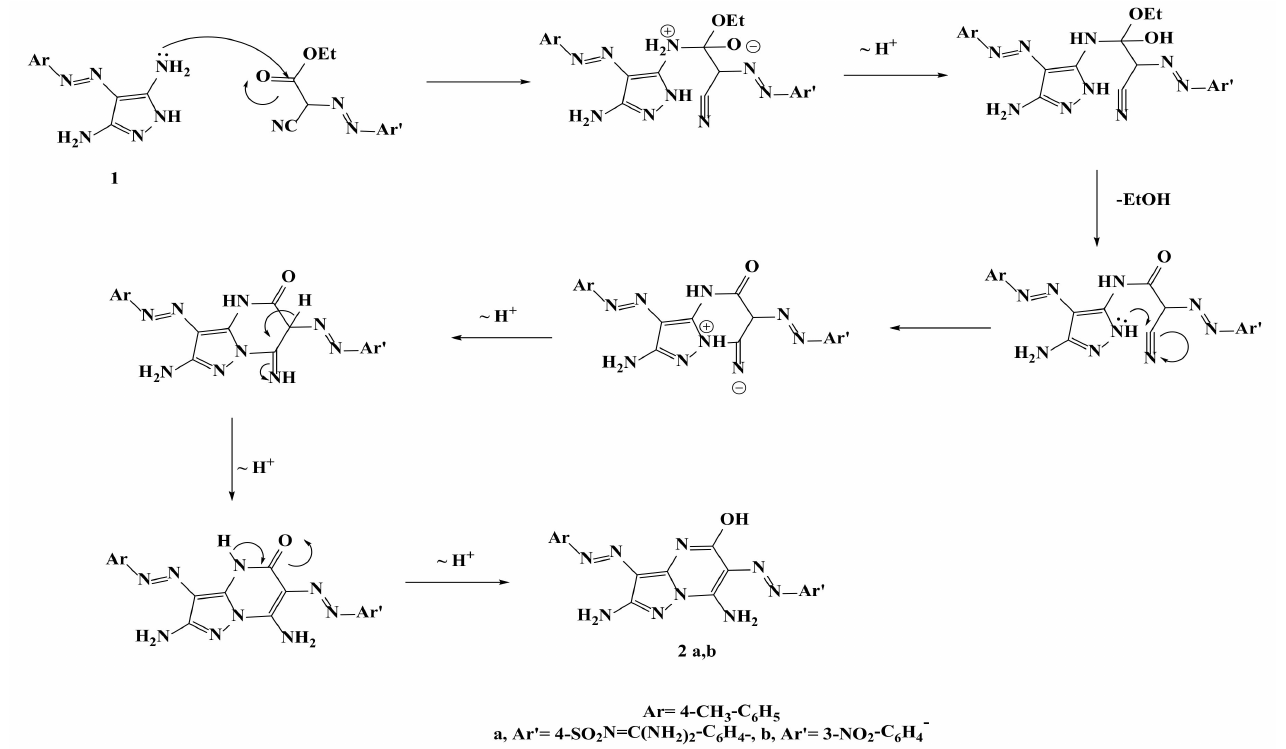
Figure 2. Mechanism of formation of pyrazolopyrimidine derivative 2a , b